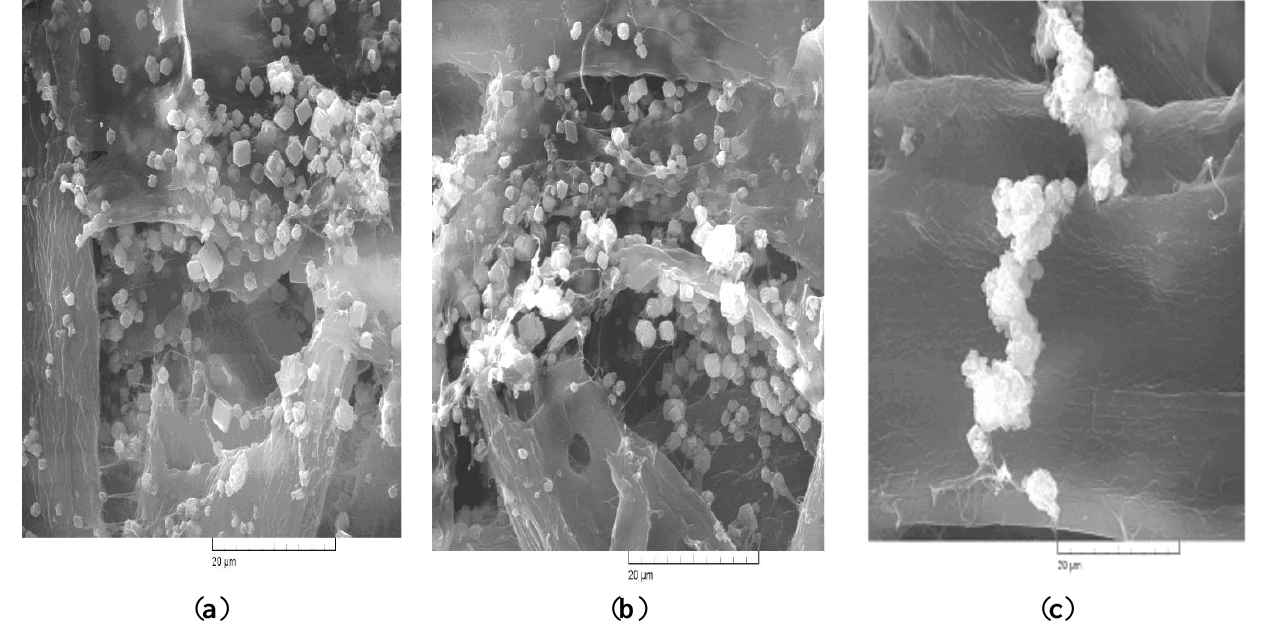
Figure 5. Scanning electron microscope (SEM) images of paper samples, obtained by conventional and respectively, in-situ loading with precipitated calcium carbonate of resinous and hardwood paper. ( a ) In-situ loading—resinous; ( b ) in-situ loading—hardwood; ( c ) conventional